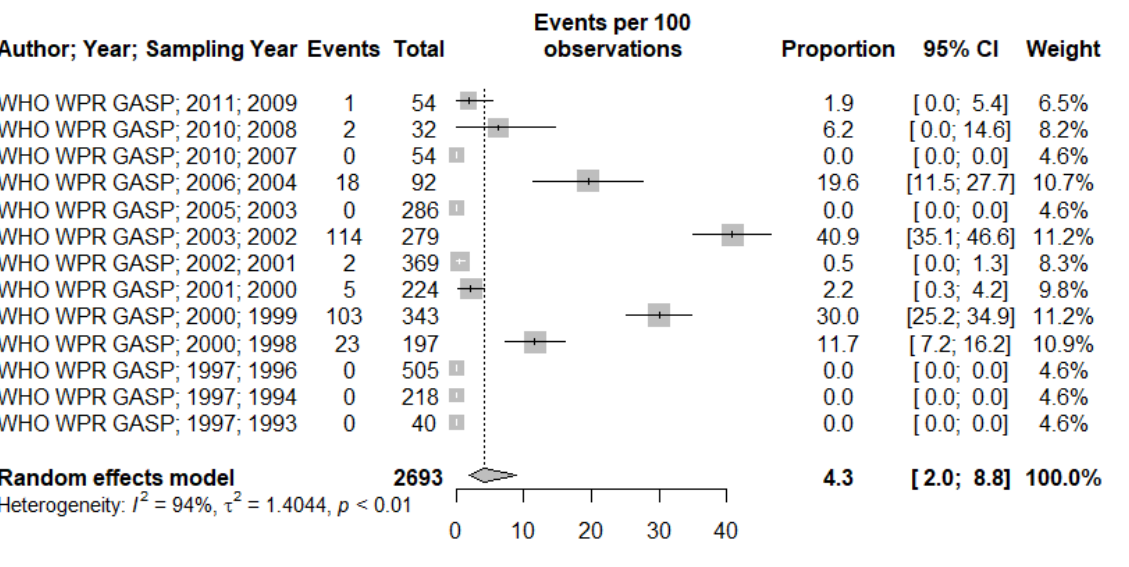
Figure 4. Tetracycline resistance prevalence estimate.